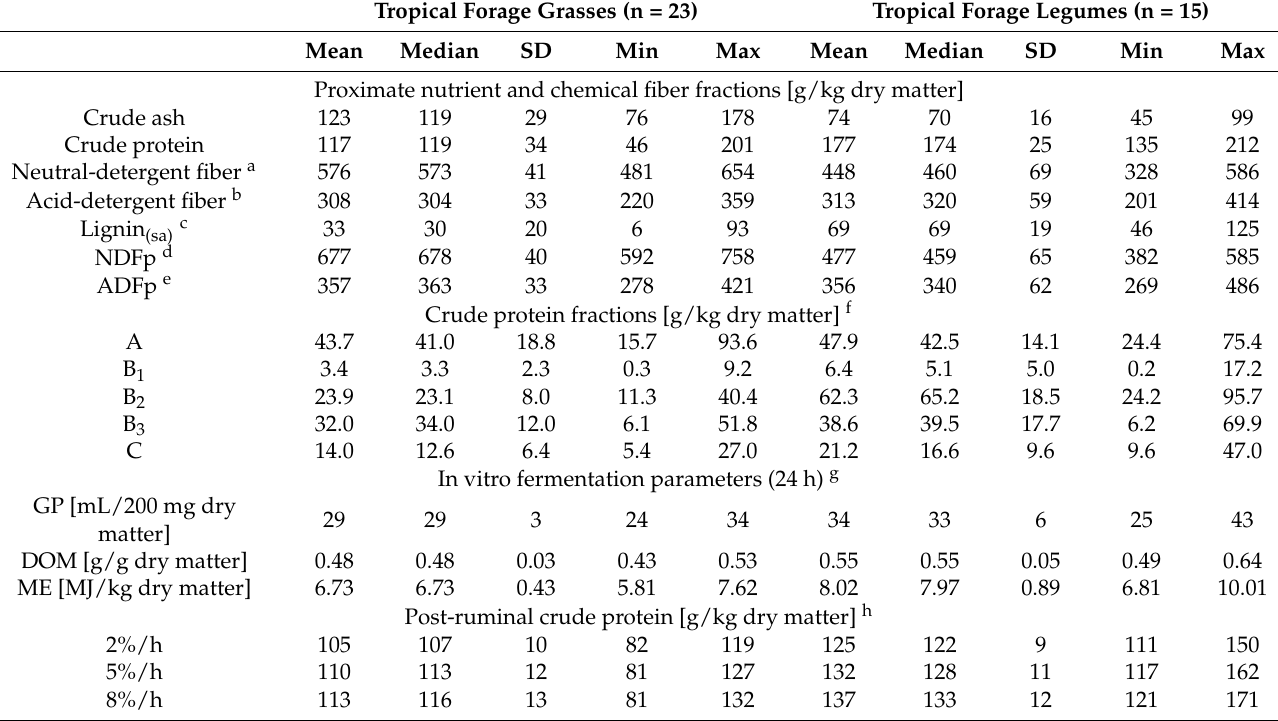
Table 1. Descriptive statistics of the concentrations of proximate nutrients, chemical fiber fractions, crude protein fractions, feed fermentation parameters after 24 h in vitro incubation, as well as the post-ruminal crude protein supply at rumen passage rates of 2, 5, and 8%/h of fresh tropical forage grasses and